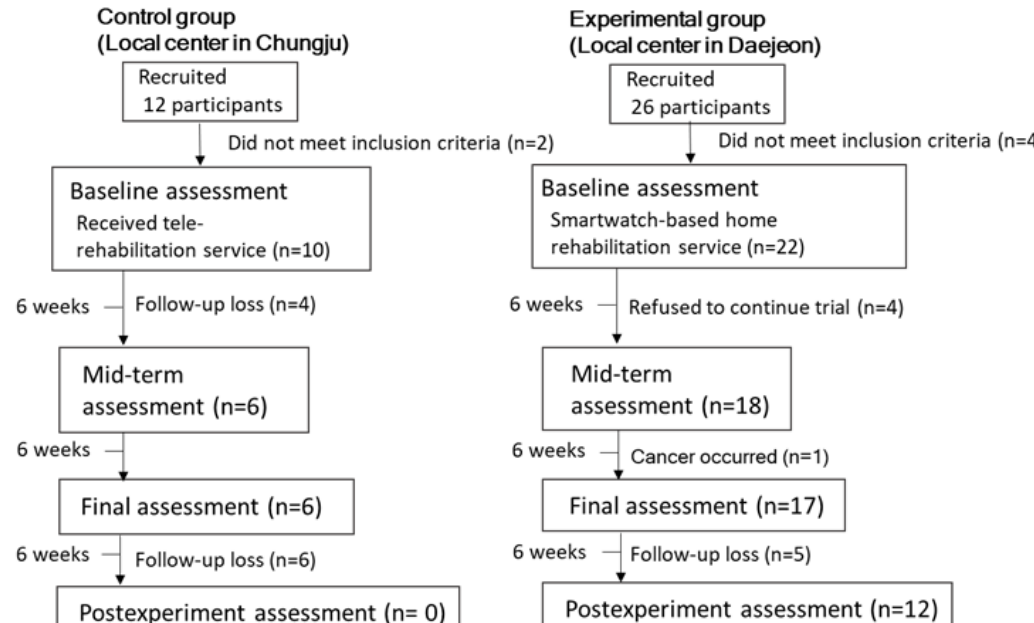
Figure 4. Time flow of the